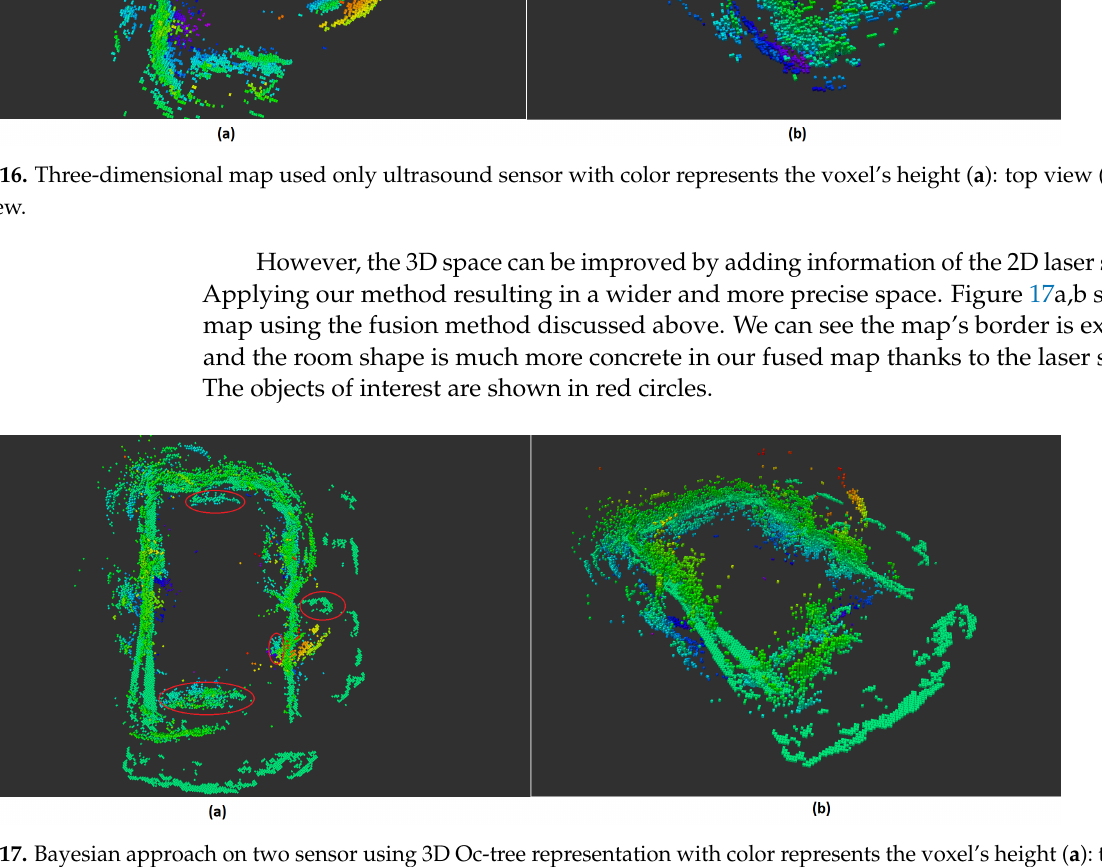
Figure 17. Bayesian approach on two sensor using 3D Oc-tree representation with color represents the voxel’s height ( a ): top view ( b ): side